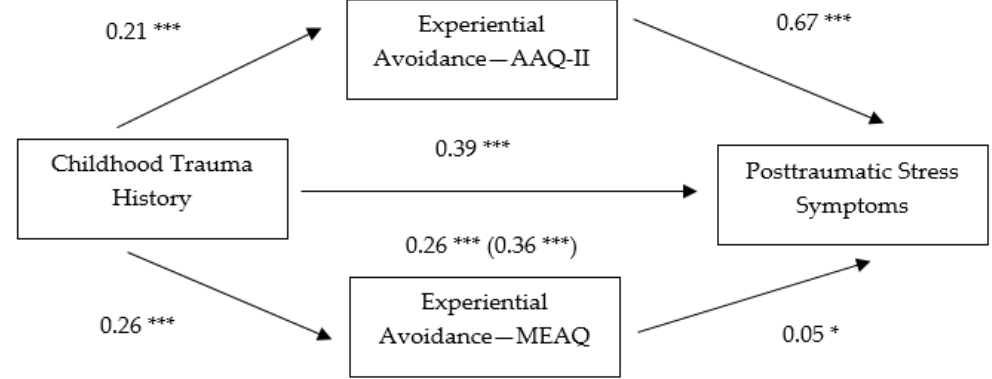
Figure 1. Indirect effect of experiential avoidance (AAQ-II and MEAQ) on the relationship between childhood trauma history and PTSS. Note: * p < 0.05, ** p < 0.01, *** p < 0.001. Path values were drawn using unstandardized regression coefficients. Parentheses indicate the total effect.